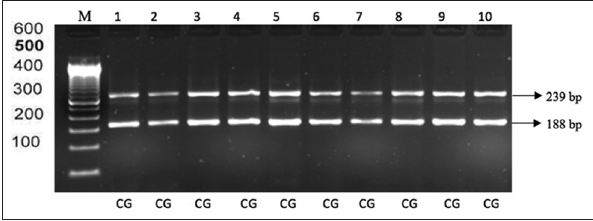
Figure-4: The electrophoresis results of polymerase chain reaction-restriction fragment length polymorphism with